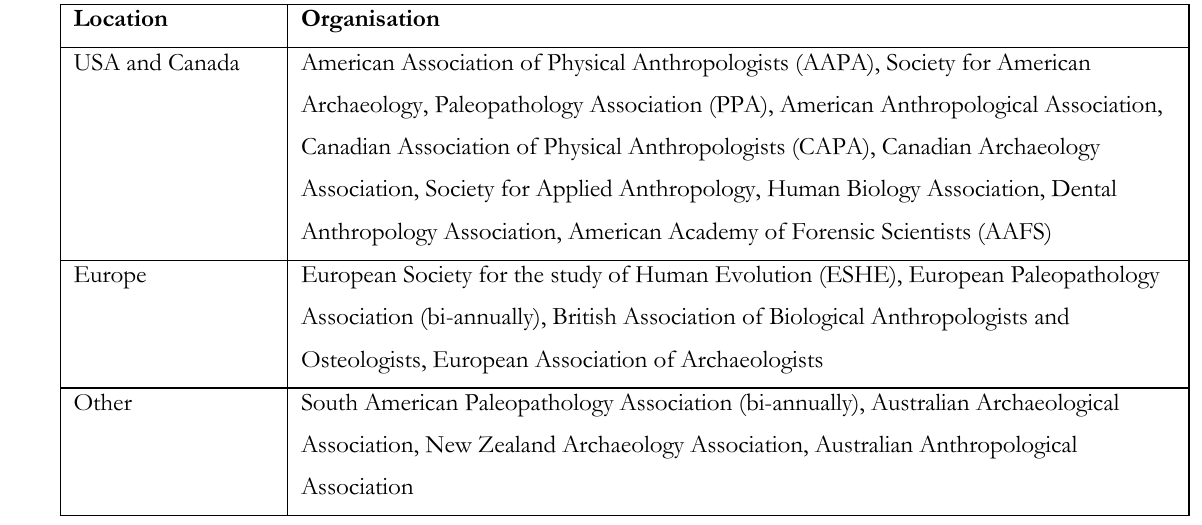
Table 1: Location of conferences in biological anthropology and bioarchaeology, excluding conferences that solely focus on research conducted in the specific regions or countries where they are